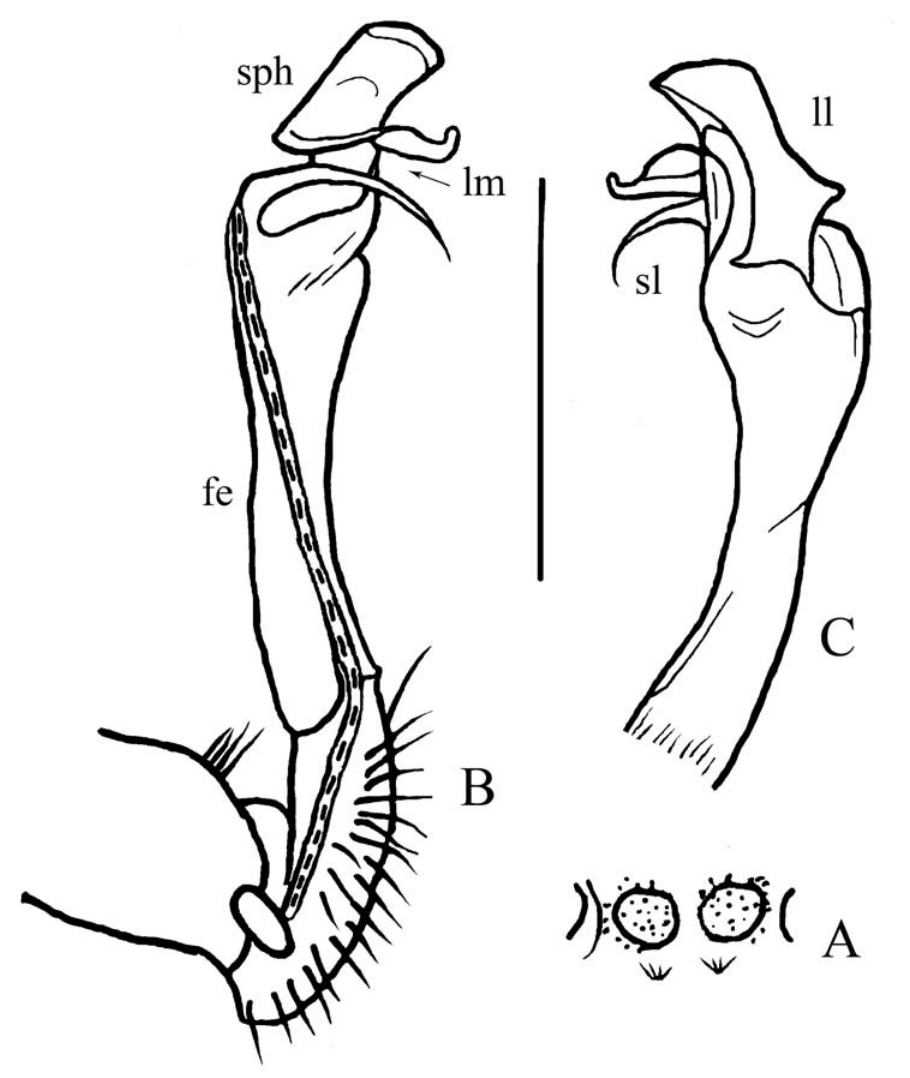
Figure 4. Desmoxytes spinissima sp. n., ♂ holotype. A sternal cones between coxae 4, ventral view B–C left gonopod, mesal and lateral views, respectively. Scale bar: 1.0 ( A ) and 0.5 mm ( B, C ). Designations: fe femorite sph solenophore sl solenomere ll lamina lateralis lm lamina